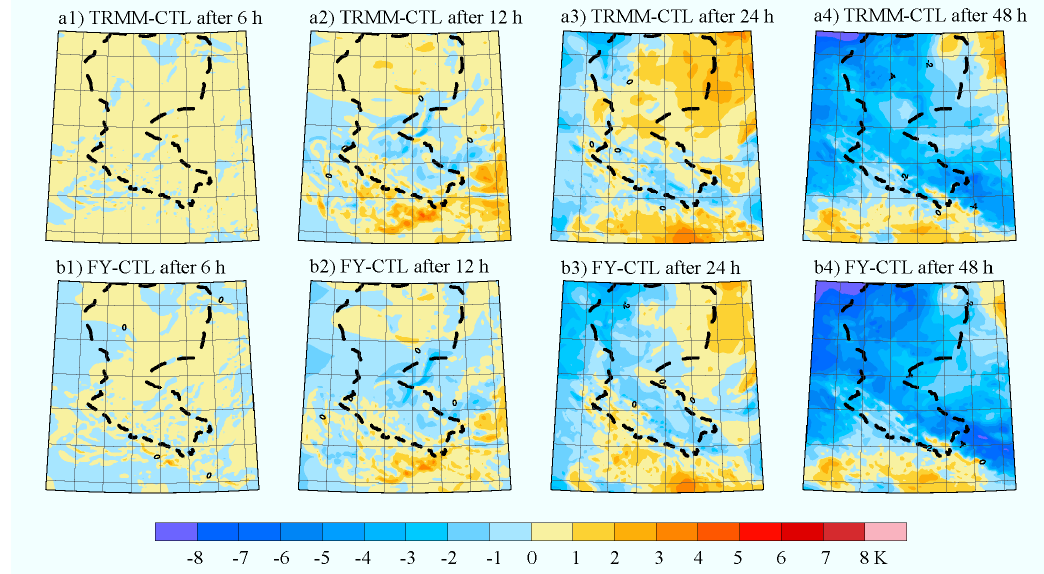
Figure 6. Spatial distribution of temperature (K) forecasting difference in the ninth model layer at 6 h, 12 h, 24 h, and 48 h: (a1–a4) for TRMM assimilation minus control simulation; (b1–b4) for FY assimilation minus control simulation.